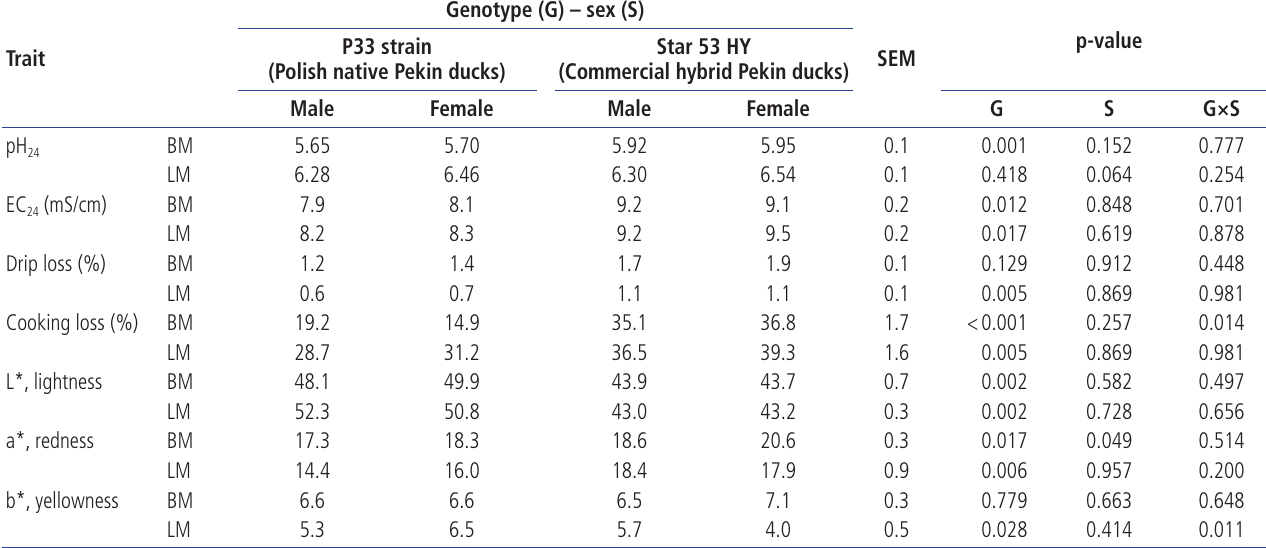
Table 6. Some physicochemical traits of breast and leg meat from 49-d-old Pekin ducks of different genotypes